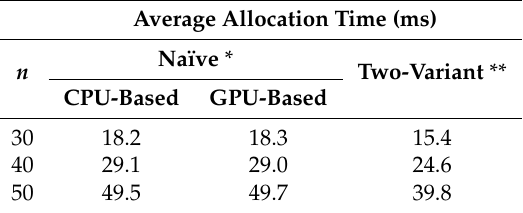
Table 1. The time used to compute allocation